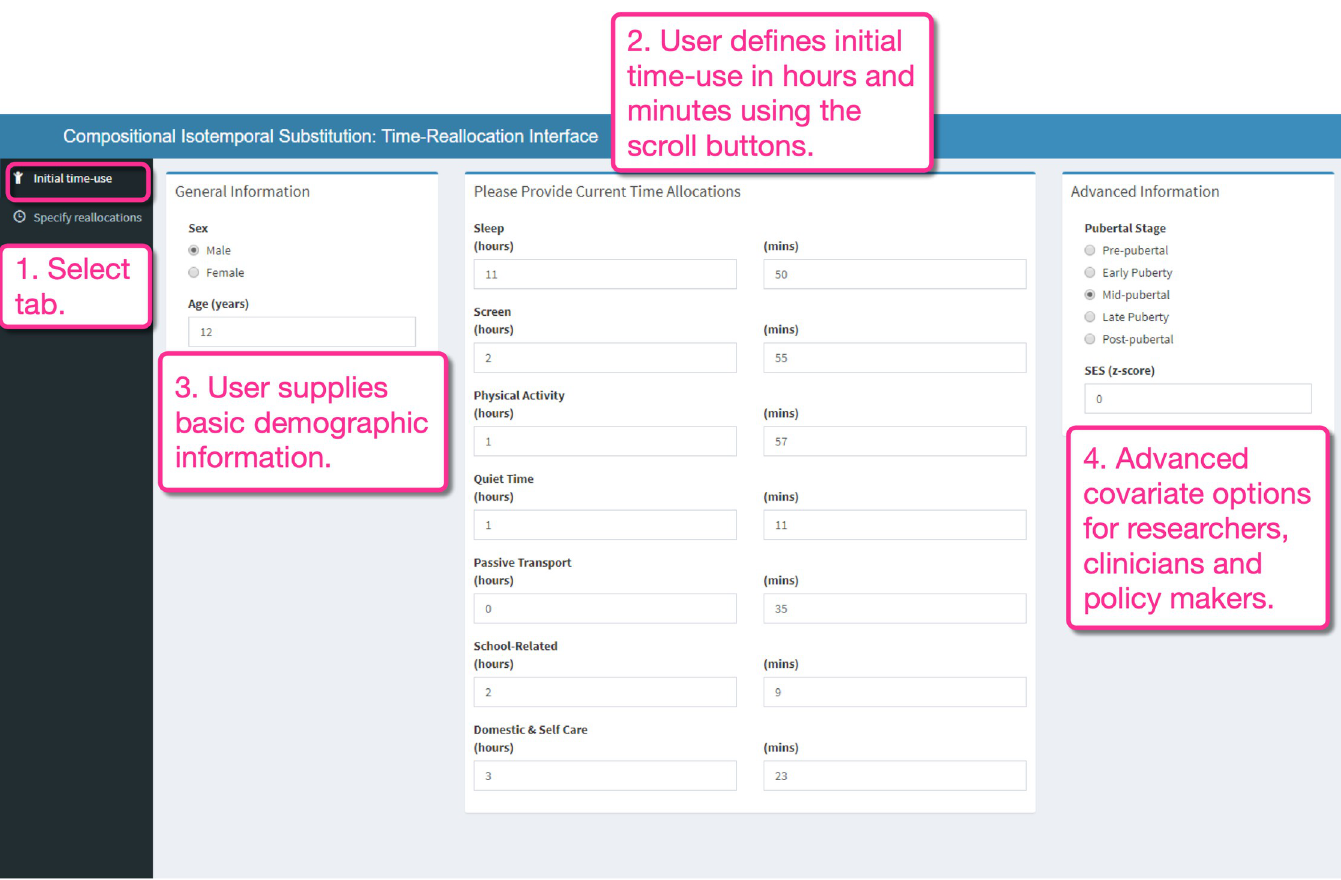
Fig 1. Shiny app interface. The initial time-use tab. To use the app to generate estimates for self-selected time reallocations, the user must first specify demographics and initial time-use variables.